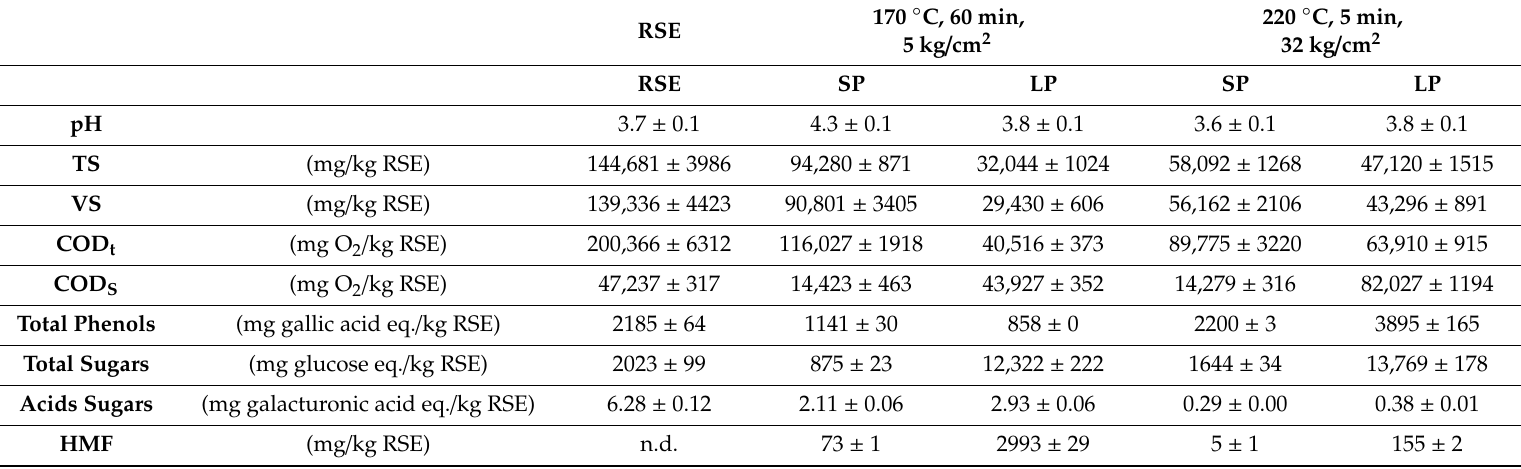
Table 1. Physicochemical characterization of untreated RSE and di ff erent treated phases (mean values ± standard deviations; n.d.: